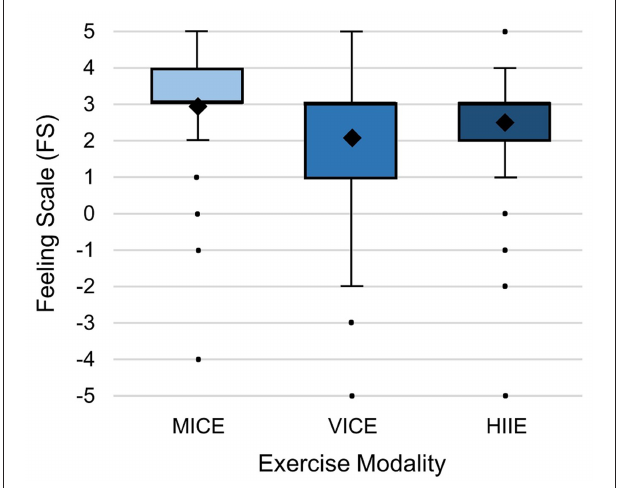
FIGURE 3 | Affective valence (Feeling Scale) and its variation within the three different exercise modalities: MICE, moderate-intensity continuous exercise; VICE, vigorous-intensity continuous exercise; HIIE, high-intensity interval exercise. The diamonds represent the mean values. Raw data is presented for the in-task time points (t 1 , t 2 ) of each of the three sessions (Ses 1 − 3 ) without adjustment for the dependencies within clusters.